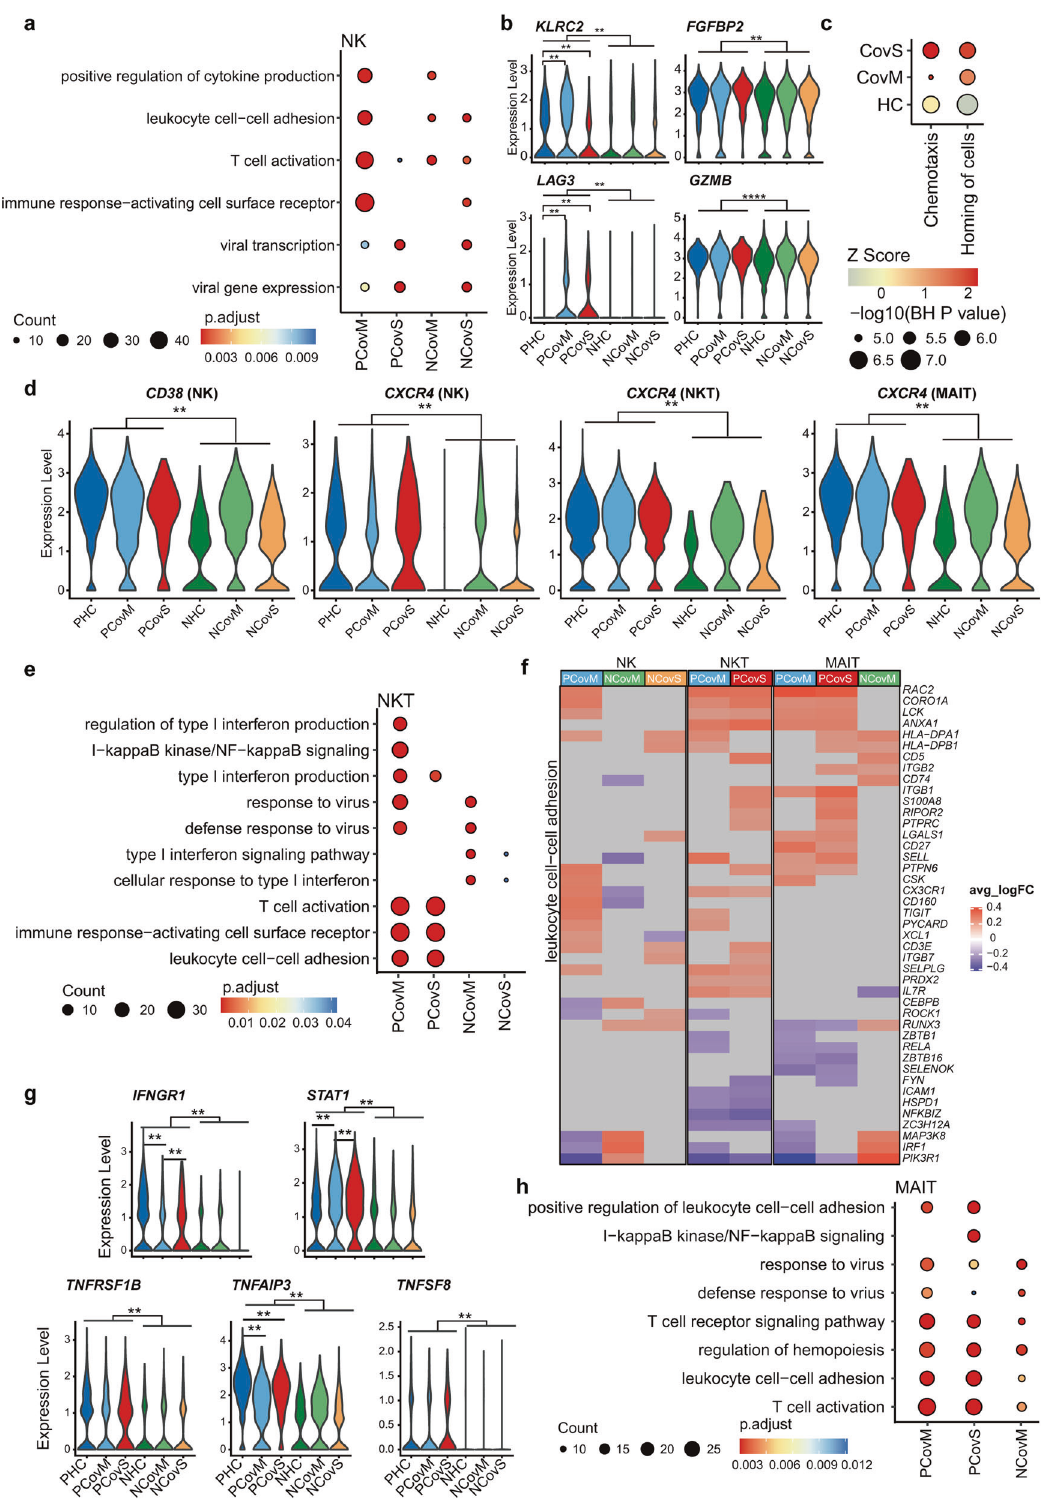
the third trimester. 46,47 However, similar level of the clonal expansion was found between the PCov and NCov groups, further supporting our previous observation that the T cell compartment was functional during pregnancy. Many innate immune cells, including monocyte and NK cells, and innate-like cells, NKT and MAIT cells, were reported